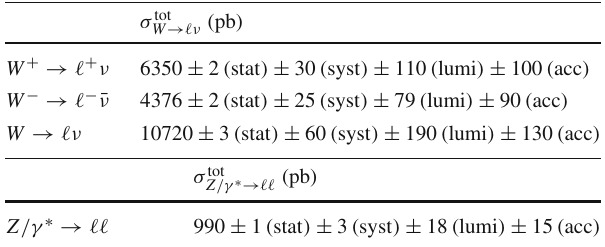
Table 10 Ratios of total CC and NC cross sections obtained from the combination of electron and muon channels with statistical and system- atic uncertainties. The Z /γ ∗ cross section is defined for the dilepton mass window 66 < m (cid:3)(cid:3) < 116 GeV. The uncertainties denote the sta- tistical (stat), the experimental systematic (syst), the luminosity (lumi), and acceptance extrapolation (acc) contributions R tot W + / W